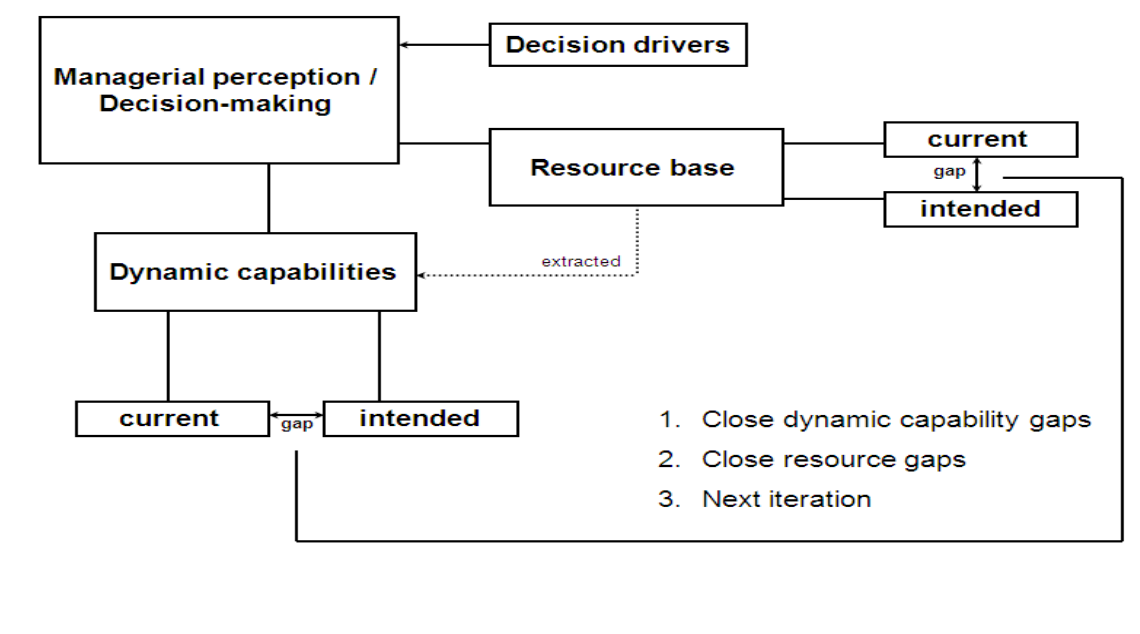
Figure 2: Strategy formation and the role of dynamic